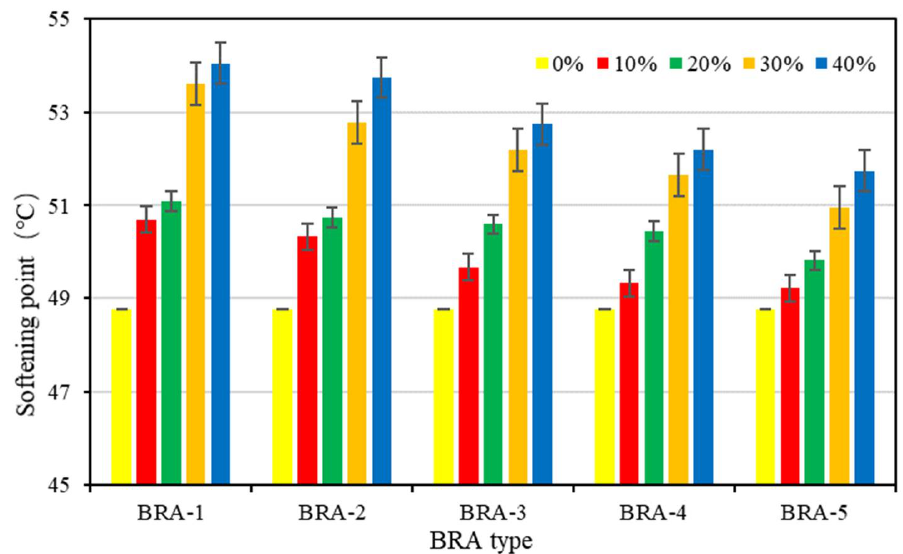
Figure 6. Softening point of base asphalt and BRA-MA.